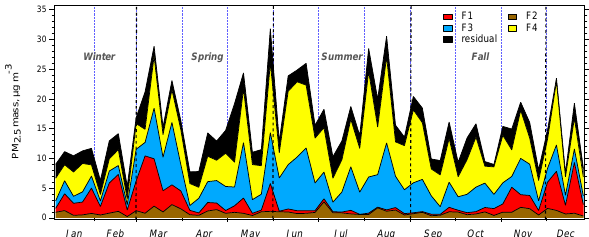
Fig. 11. Time series of PM 2 . 5 composition by four factors re- solved by PMF and masses predicted by multivariant linear regres- sion